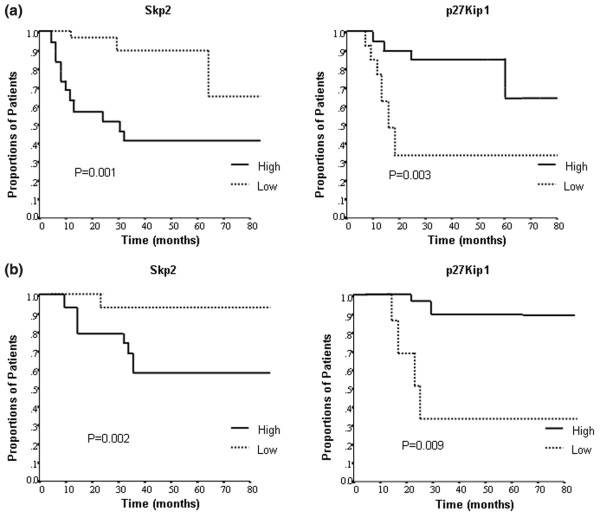
Pretreatment Skp2 and p27Kip1 expression levels and survival. Shown are the associations between pretreatment Skp2 or p27Kip1 expression and (a) disease-free survival and (b) overall survival rates. Analyses were constructed using the Kaplan-Meier method. KIP, kinase inhibitor protein; Skp2, S-phase kinase protein 2.